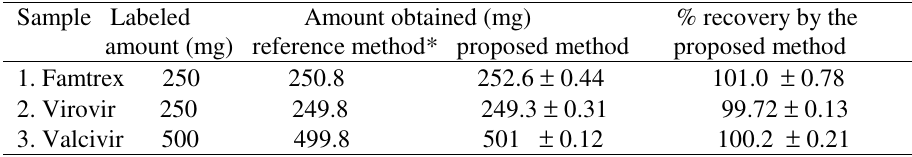
Table 2. Assay of Famciclovir and Valacyclovir in Pharmaceutical Formulations